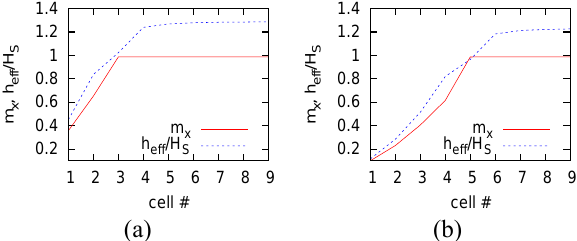
Figure 8: Simulation results of the direct method with (a) 1, (b) 8, and (c) 128 cells.